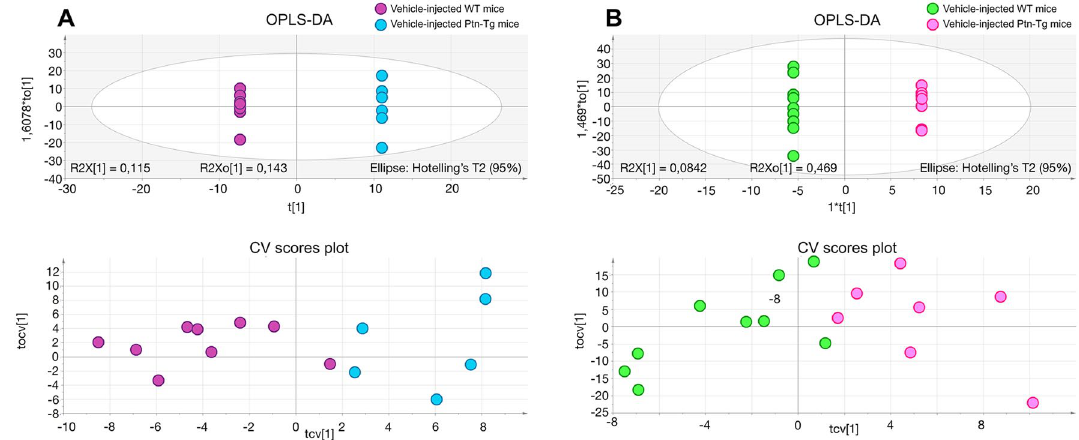
Figure 5. OPLS-DA regression models and cross-validated (CV) score plots showing differentiation of the metabolic profiles between vehicle-injected Wt mice and vehicle-injected Ptn -Tg mice in positive ( a , R 2 = 0.927, Q 2 = 0.686) and negative ( b , R 2 = 0. 968, Q 2 = 0.605) ionization